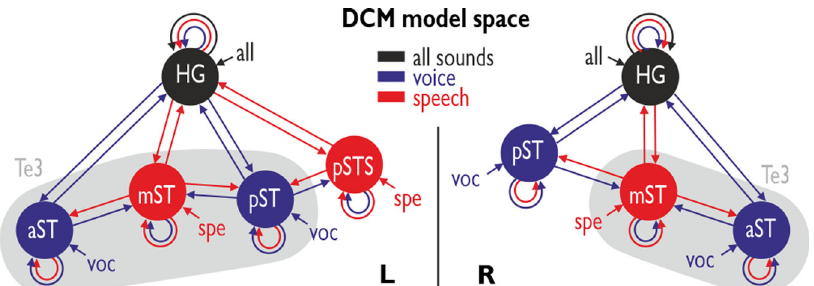
Fig. 2 DCM model space. Model space for the DCM analysis including three conditions (all sounds, voice sounds, speech sounds). The full model included driving inputs to each node from different conditions (arrows to nodes), intrinsic connections for each node (circular arrows), bidirectional extrinsic connections between neighboring nodes (straight arrows), and modulations of connections by conditions (color of arrows). Gray shading indicates the auditory area Te3. Black regions were de fi ned based on their activity to all sounds, blue regions were de fi ned based on their activity in the [voice>non- voice] contrasts, and red region were de fi ned by their activity in the [speech>nonverbal] contrast.